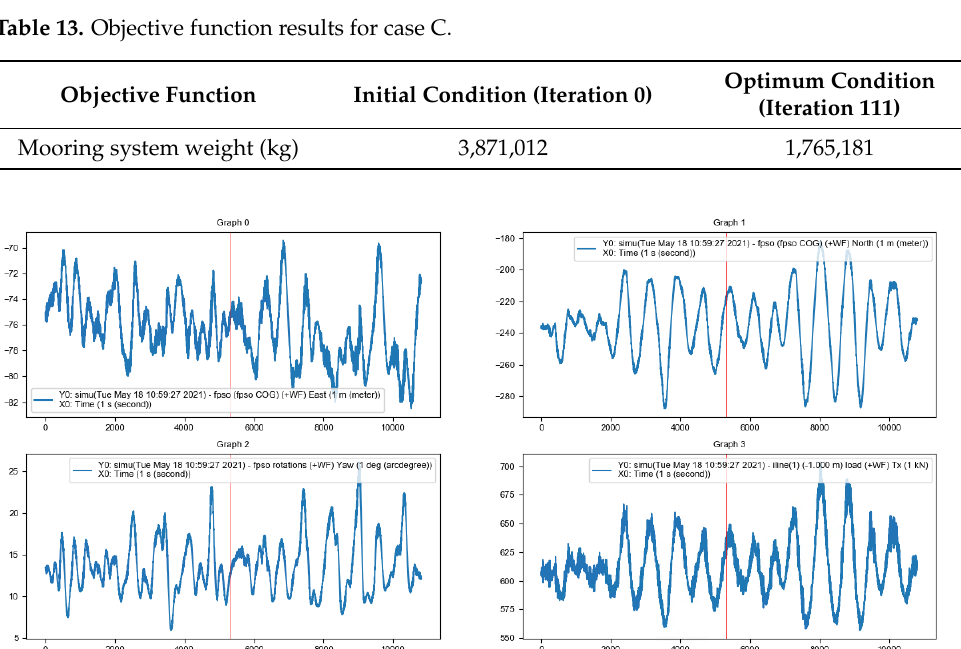
Table 13. Objective function results for case C.